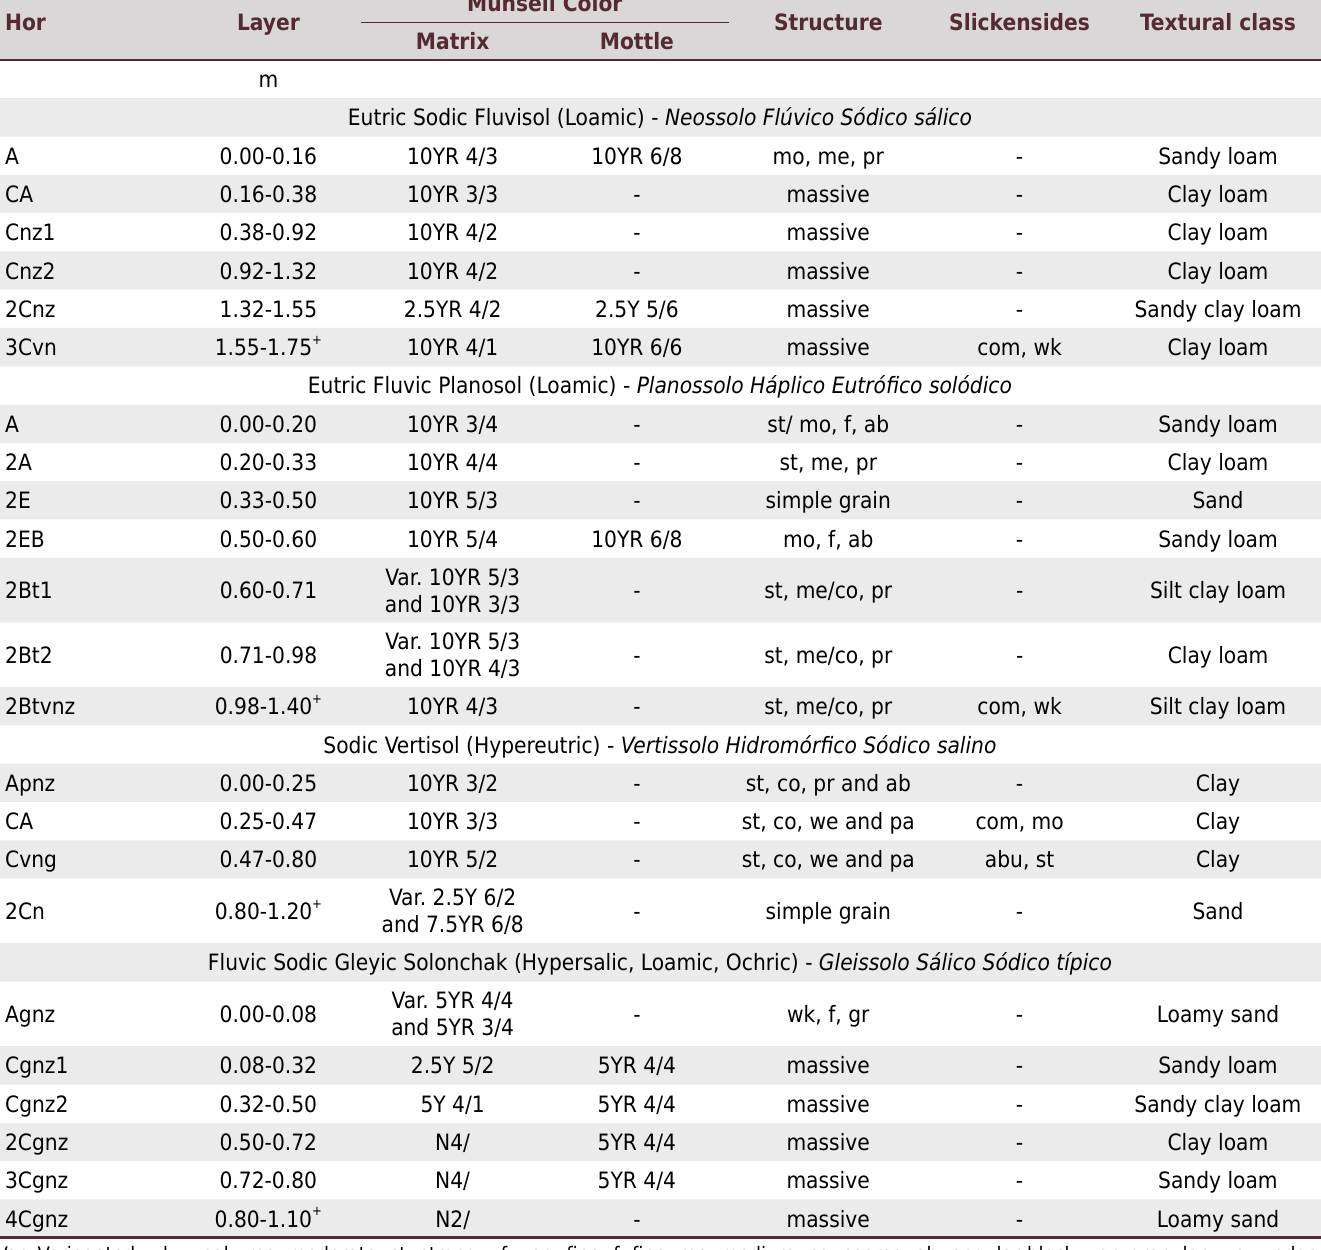
Table 2. Morphological properties of soil profiles of lower course of the Acaraú River (Ceará State, Brazil) Hor Layer